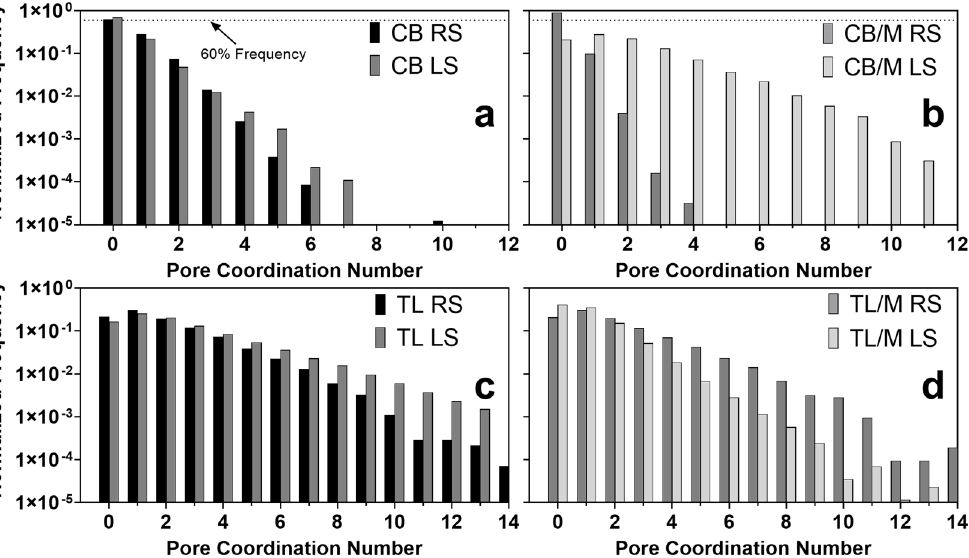
Figure 5. Pore coordination number distributions for 500 s − 1 sheared samples, ( a , b ) cocoa butter and ( c , d ) trilaurin. Distributions presented were computed by taking an average of replicate distributions to represent the average distribution observed. Table 2. Pore connectivity (z), volume weighted pore and throat radii (R 43 ), and void fraction (v).